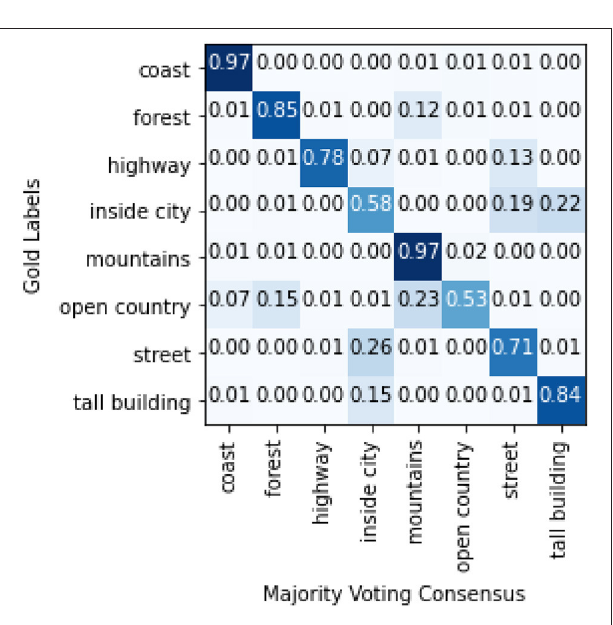
FIGURE 5 | Confusion matrix between gold labels and majority voting consensus for